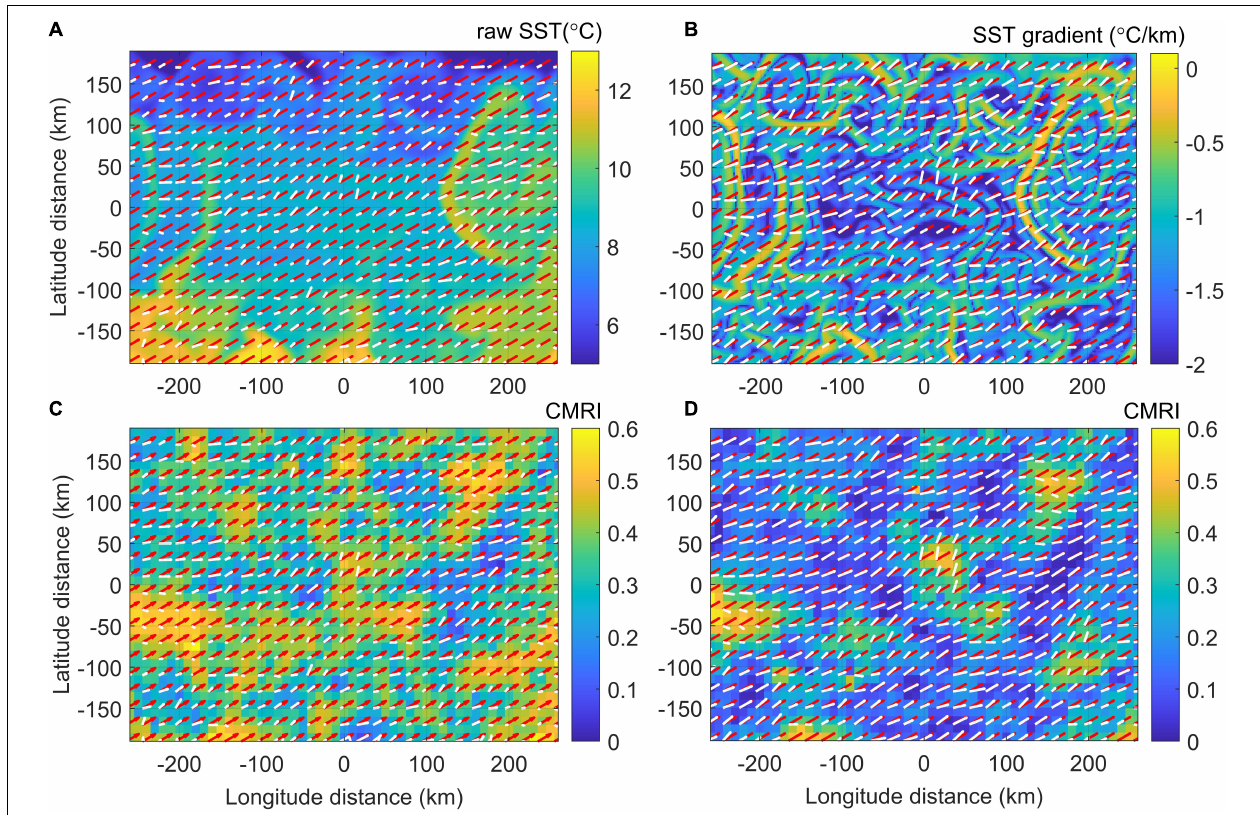
FIGURE 1 | Example comparison of true velocity field V true in a 10 km-grid (red arrows) and calculated velocity field V cal in a 10 km-grid (white arrows) for raw SST (A) and SST gradient (B) . Contours in panels (C,D) show CMRI errors corresponding to panels (A,B) ,